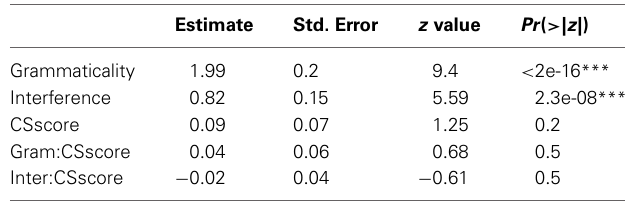
Table 7 | Number-agreement acceptance rate: fixed effects from the mixed effect logistic